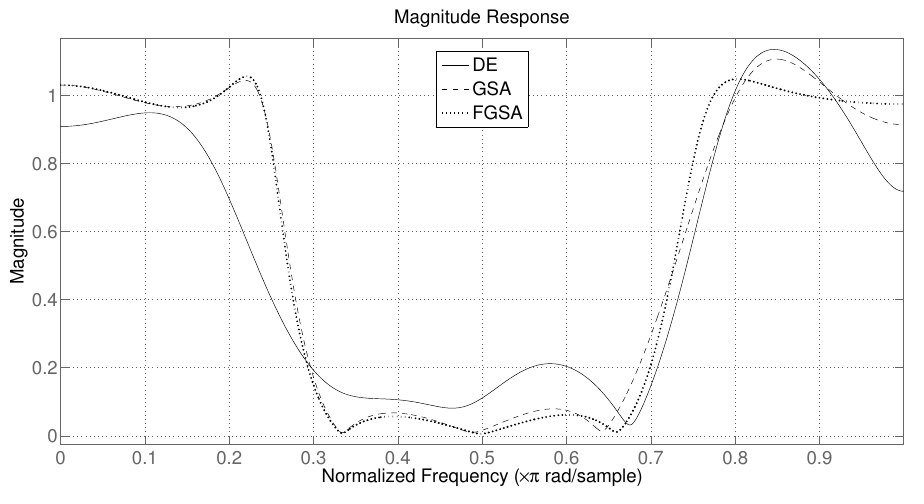
Figure 10. Magnitude response over normalized frequency for 8th order IIR Stop Band filter using DE, GSA and